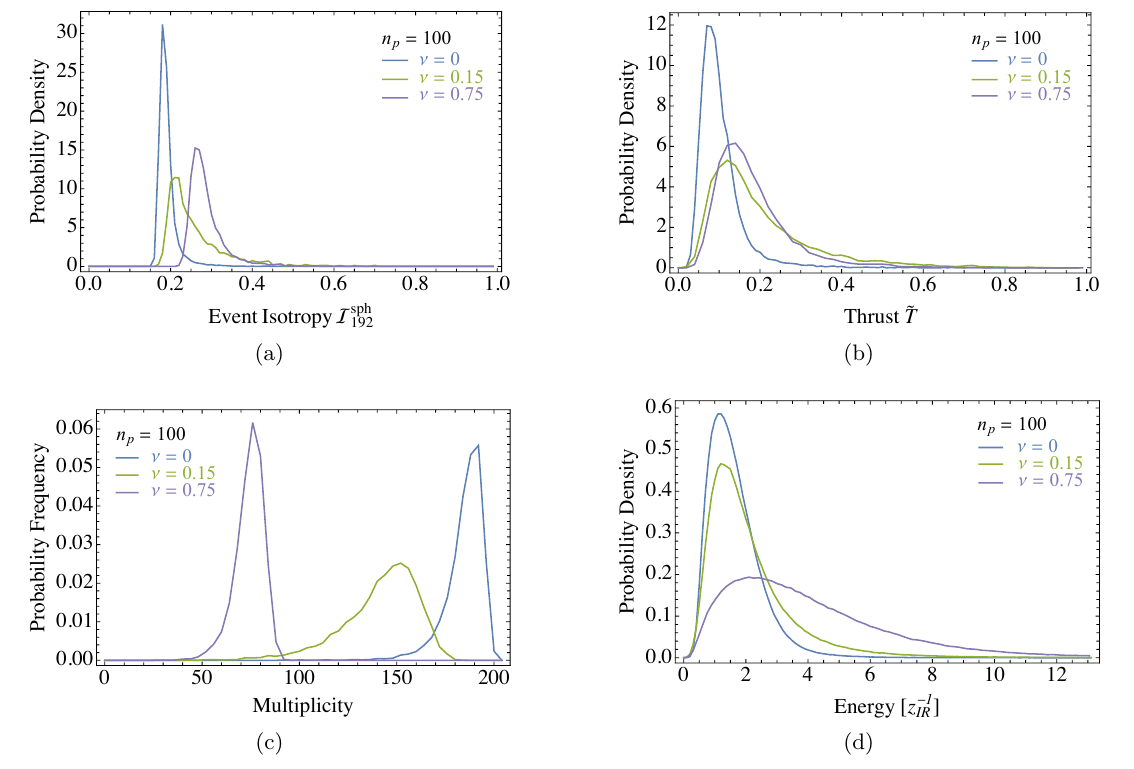
Figure 5 . The (a) event isotropy, (b) thrust, (c) multiplicity, and (d) energy spectra of the final state of ν = { 0 , 0 . 15 , 0 . 75 } cascades. The samples comprise 10 4 events with n state observables are computed after splitting the HSHs into two massless